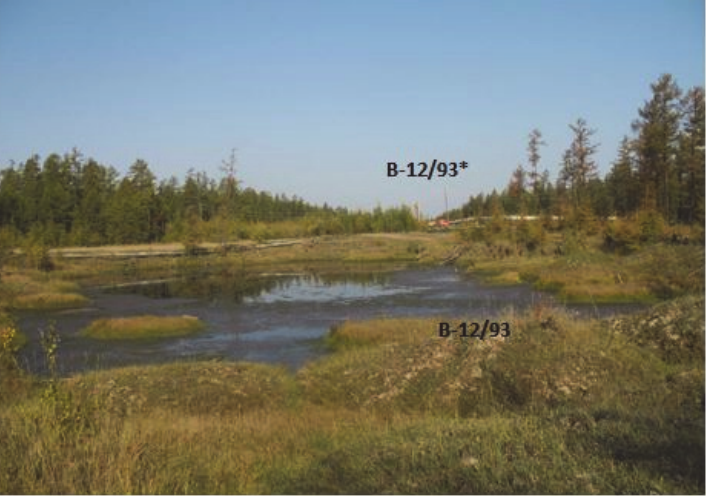
Figure 8. Early stage of thermokarst, August 2009. View from the old damaged borehole B-12/93 (in front of the lake). New Borehole B-12/93* in the background (near the rig).